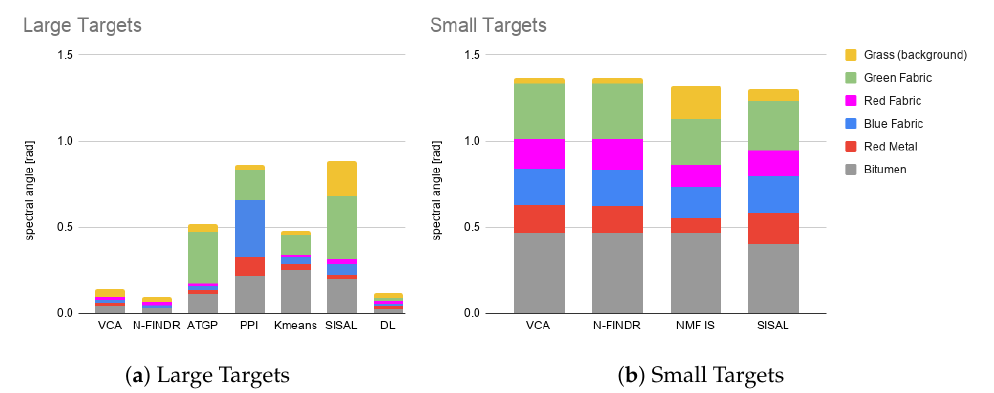
Figure 6. Spectral angle between endmembers extracted by different EE algorithms and the HySpex reference spectra reported in Figure 5. The algorithms have been applied to the subset containing the large 3m targets only ( a ), which should be the easier case, and on the scenario containing no pure endmembers ( b ), which is a highly mixed scenario. VCA and N-FINDR algorithms retrieve the correct spectra with the least amount of distortion for the large targets (see also Figure 7), while the SISAL [37] and NMF algorithms operating without the pure pixel assumption obtain slightly better results in the mixed scenario. The results of dictionary learning (DL) will be discussed in Section